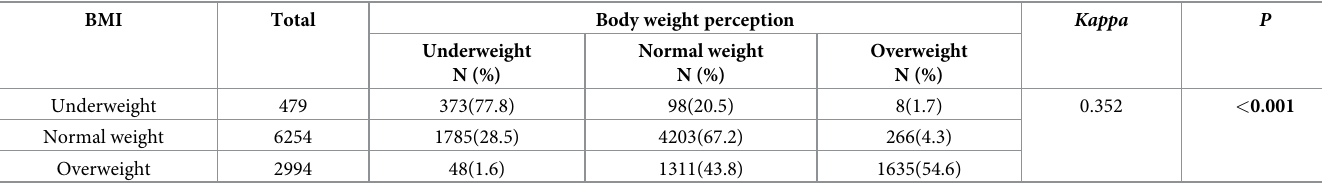
Table 4 provides consistency analysis of BMI and body weight perception. Kappa tests